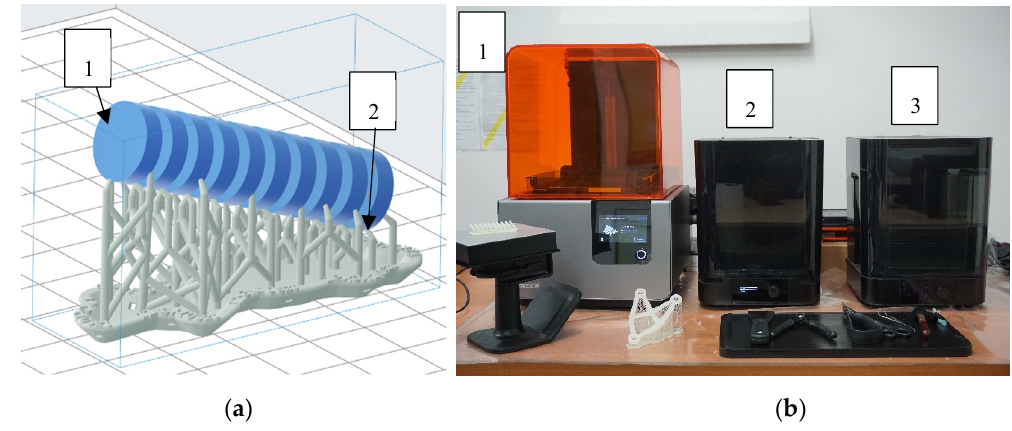
Figure 5. Sample preparation: ( a ) samples designed in PreForm software (1—samples, 2—supports), ( b ) Formlabs setup: 1—SLA printer, 2—curing chamber (UV and heat exposition), 3—cleaning chamber for isopropanol bath.